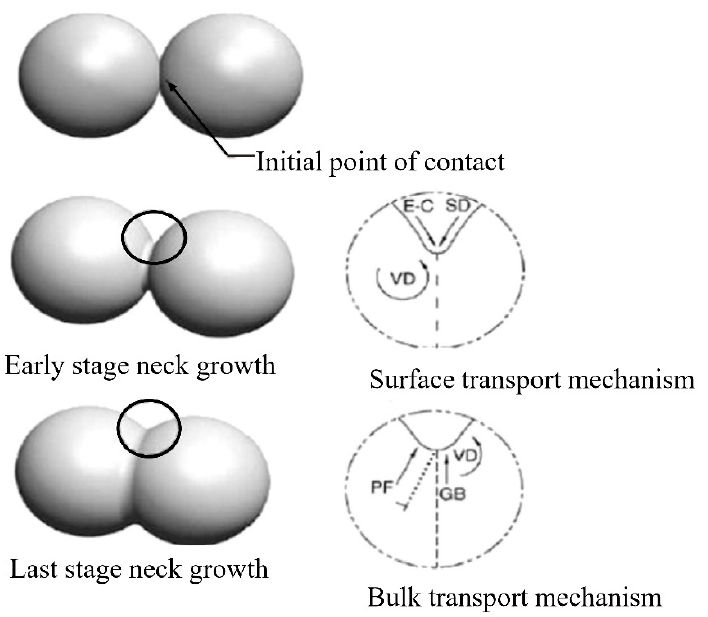
Figure 15. Two-sphere sintering model. Reproduced with permission from reference [42], copyright © 2016 Elsevier B.V.